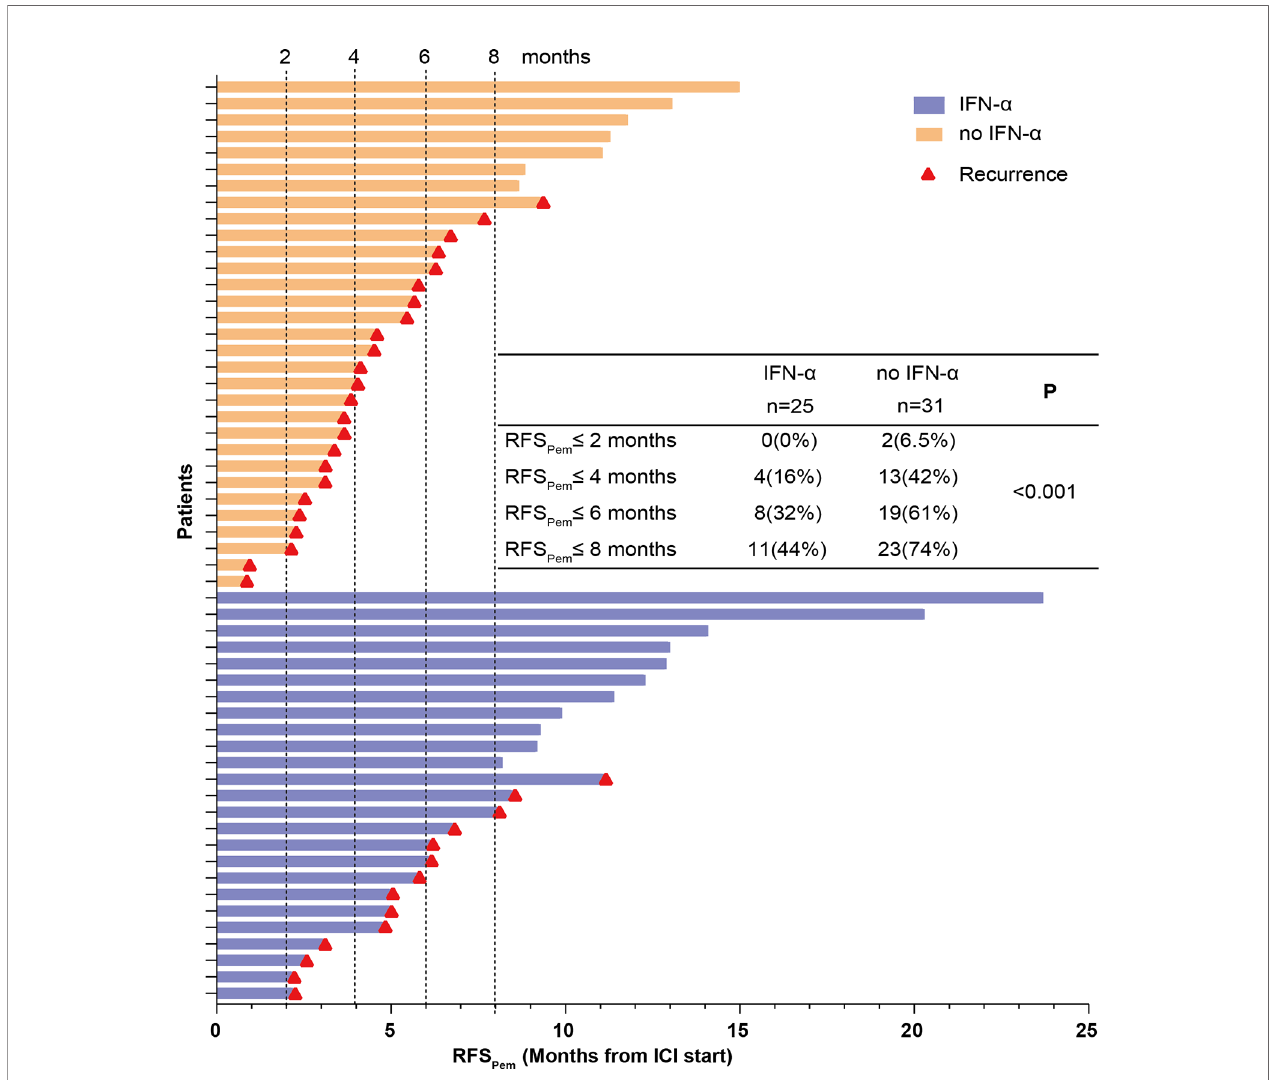
FIGURE 4 | RFS Pem of all patients was summarized. Each row represents one patient. The length of each bar shows the time from start of adjuvant pembrolizumab treatment to the recurrence or the last follow-up. The red triangle indicates patients who developed a recurrence. The numbers and proportions of patients who developed a recurrence at different time points were calculated. The P value was generated from the Chi-Square test to compare the recurrence rates between the IFN- a and no IFN- a groups.